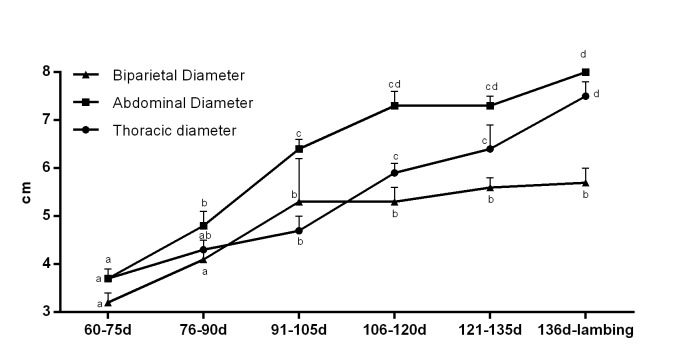
Thoracic, abdominal and biparietal diameters (cm) of ovine fetuses throughout pregnancy (n=13). a-dindicate significant differences between time (P<0.05).